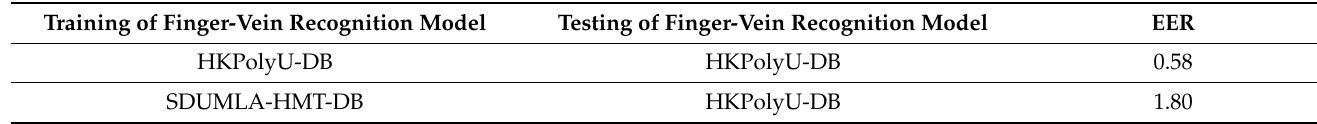
Table 6. Comparisons of EER with same domain and cross-domain environment without our domain adaptation method (unit: %). Training of Finger-Vein Recognition